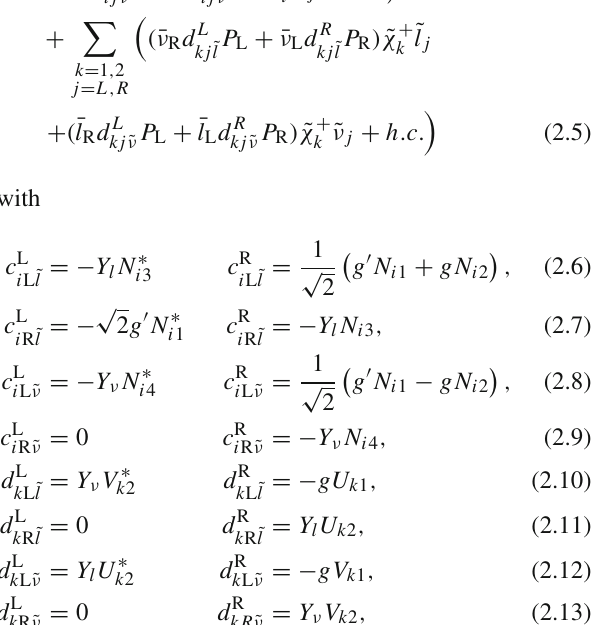
) + σ( pp → ˜ e ∗ ˜ ν ) , green (bright) eL eL L ) , red (dark) full line σ( pp → ˜ e ˜ e ∗ ) and L eL L ) . ˜ M is either the soft SUSY R or M ˜ depending on the particles considered L E